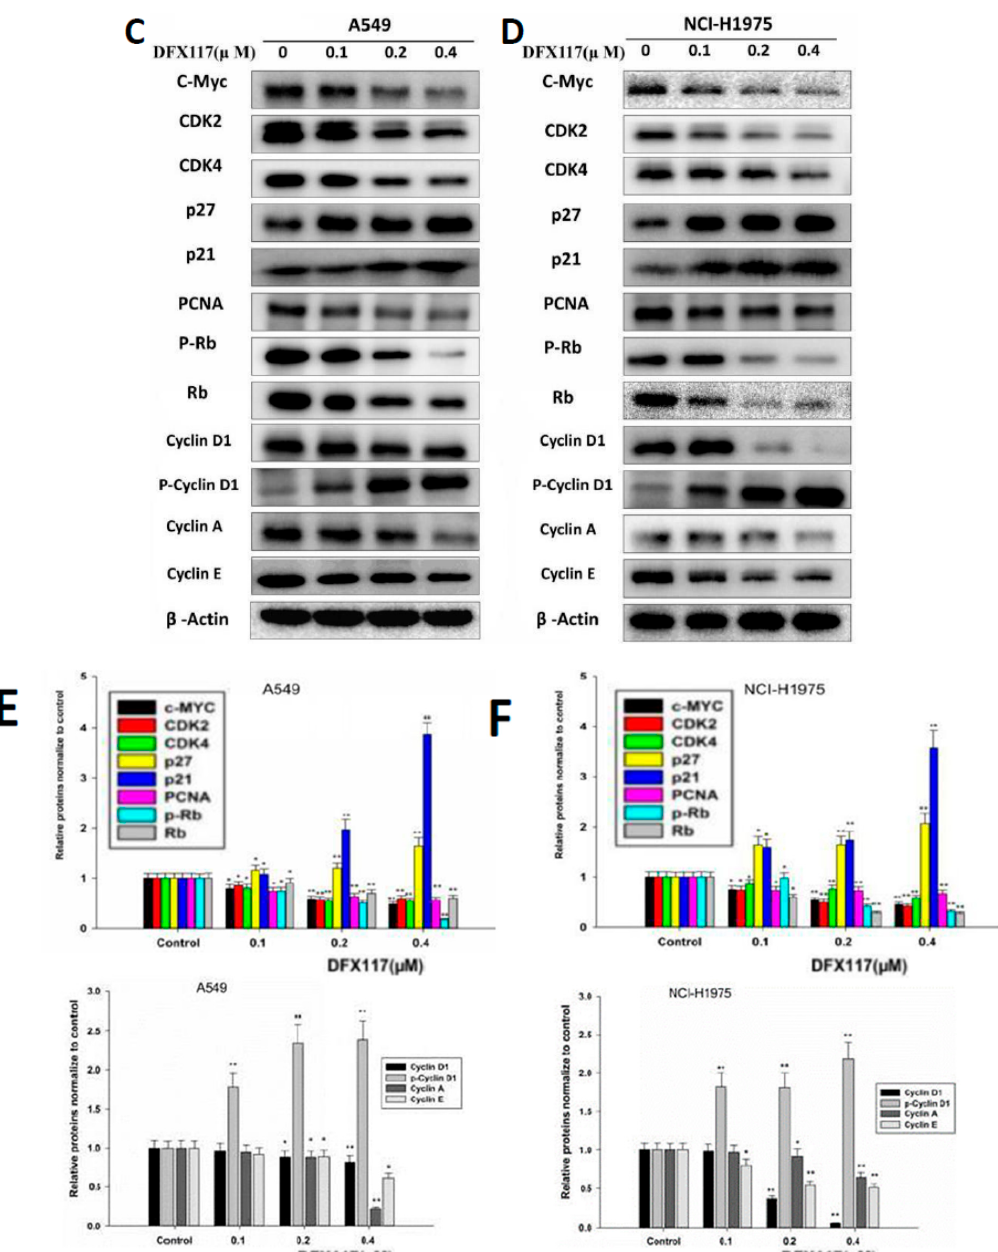
Figure 4. DFX117 altered cell cycle distribution in lung cancer cells. ( A , B ) A549 and NCI-H1975 cells were exposed or not exposed to DFX117 at indicated concentrations for 24 h and then were collected for PI (propidium iodide) staining and Western blot analysis. The DNA content was then analyzed by flow cytometric analysis as described in the Materials and Methods. ( C , D ) Cells were treated with the indicated concentrations of DFX117 for 24 h, and protein lysates were analyzed by Western blot to detect the alteration of cell cycle related proteins. ( E , F ) The changes in corresponding protein expression levels were quantified using ImageJ. Each bar represents the mean ± SEM ( n = 3); * p < 0.05 or ** p < 0.01 was considered statistically significant compared with the corresponding control values. To further evaluate whether DFX117 is able to induce apoptotic cell death after an extended exposure time in lung cancer cells, the cells were treated with DFX117 for 48 h, and Annexin V-